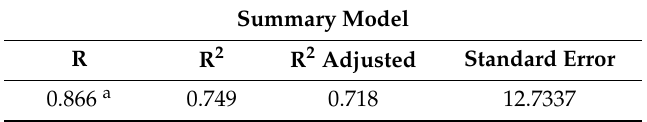
Table 6. Determination coefficients: Wheel-tracking test and first modulus of the plate bearing test.